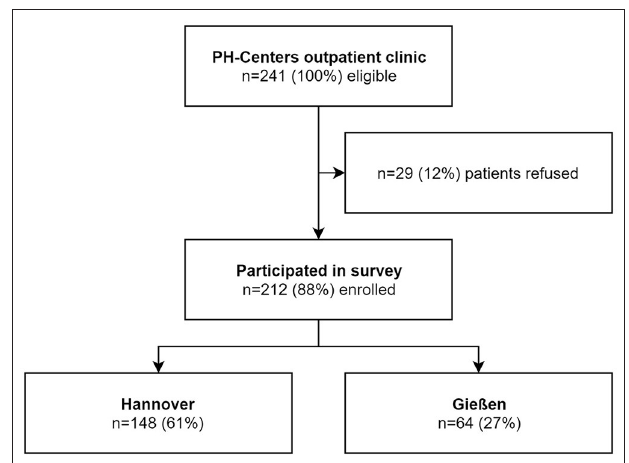
FIGURE 1 | Flow chart of study inclusion. PH, pulmonary